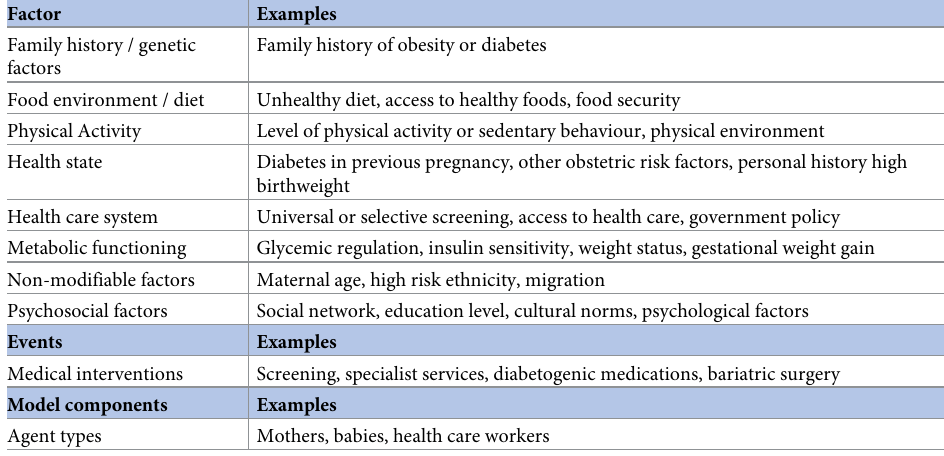
Table 1. Factors influencing the development of diabetes in pregnancy prioritised from problem